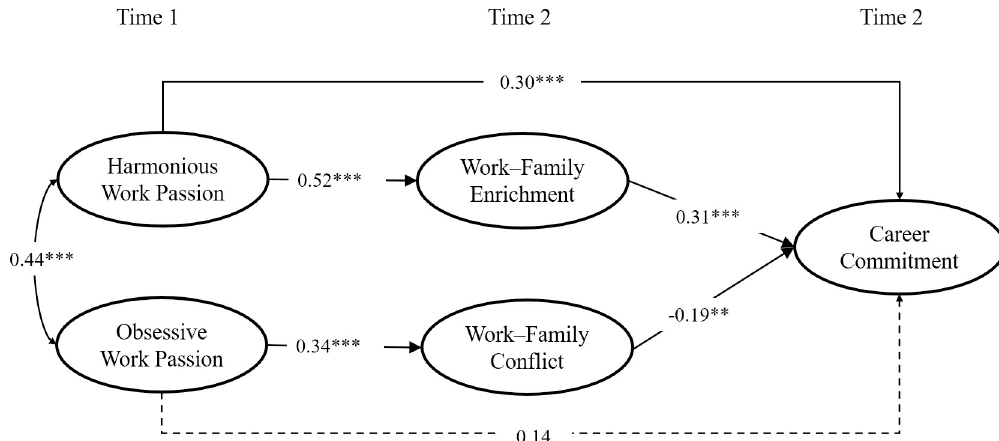
Fig 2. Standardized path coefficients for the hypothesized model. Note . Solid lines indicate significant paths and dotted lines indicate non-significant coefficient. The effects of control variables are not shown. �� p < 0.01, ��� p < 0.001.